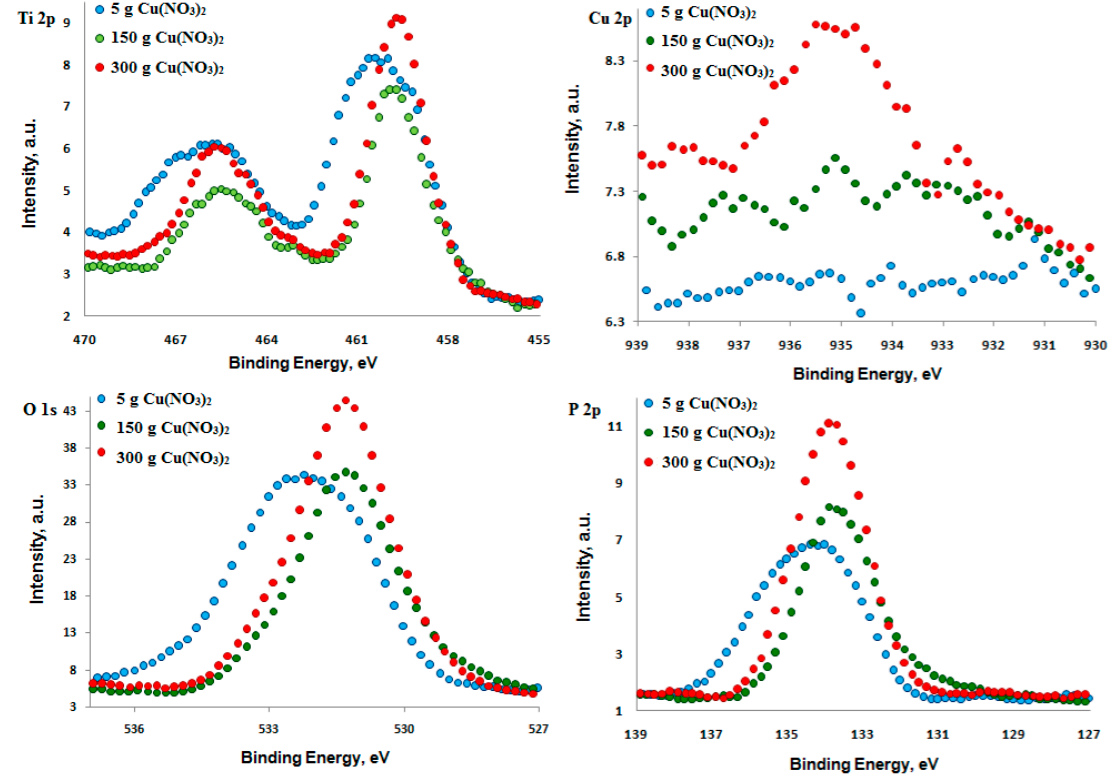
Figure 7. XPS high resolution Ti 2p, Cu 2p, O 1s, and P 2p spectra of surface layer formed on titanium alloy after PEO.